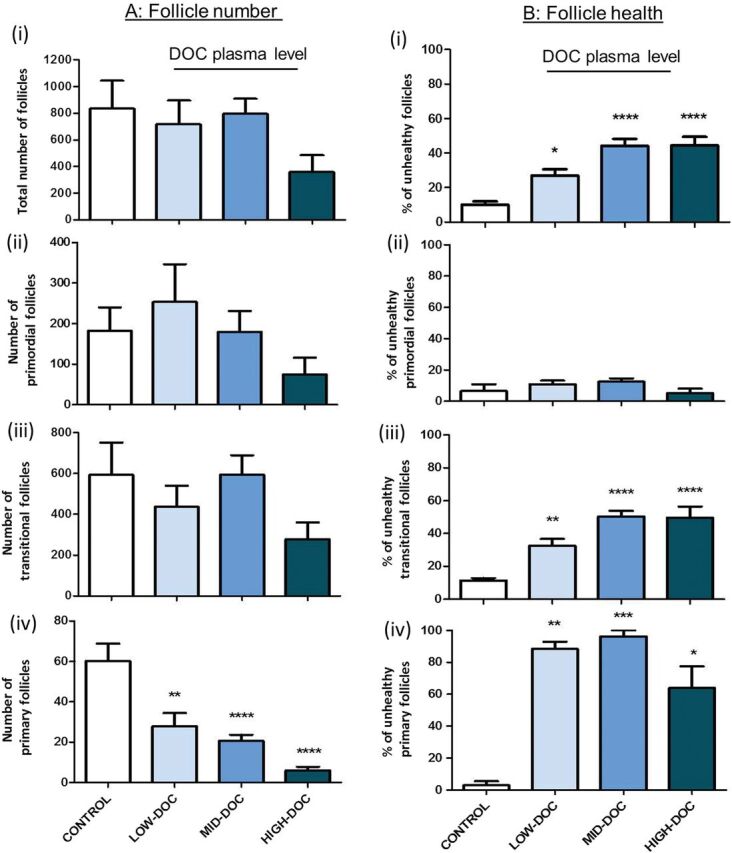
Docetaxel affects the number and health of early growing but not primordial follicles in mice. (A) Follicle number. Whole mouse ovaries were maintained in vitro for 6 days and treated with Docetaxel (DOC) for 24 h on Day 2 at concentrations of 0.1 µM (LOW-DOC), 1 µM (MID-DOC) or 10 µM (HIGH-DOC). The data show that DOC significantly decreased the number of primary follicles only. (B) Follicle health. DOC had significant effects on health in all but the primordial follicles. Total of ovaries used in three independent experiments: CONTROL = 7, LOW-DOC = 7, MID-DOC = 8 and HIGH-DOC = 7. One-way analysis of variance (ANOVA) followed by Bonferroni post hoc tests were applied. Data are mean ± SEM. P < 0.05 (*), P < 0.01 (**), P < 0.001 (***), P < 0.0001 (****) for DOC versus CONTROL.